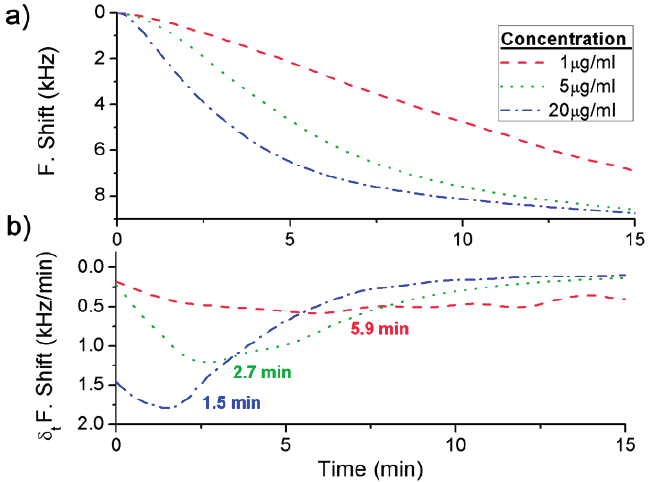
Figure 4. Frequency shift for ( a ) the measurements in real time of the different concentrations of the Rabbit IgG and ( b ) their derivate with respect to